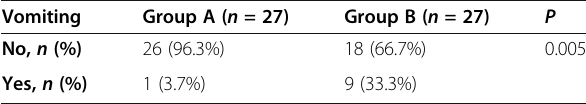
Table 8 Comparison between the two groups regarding vomiting during the 48 h from operation